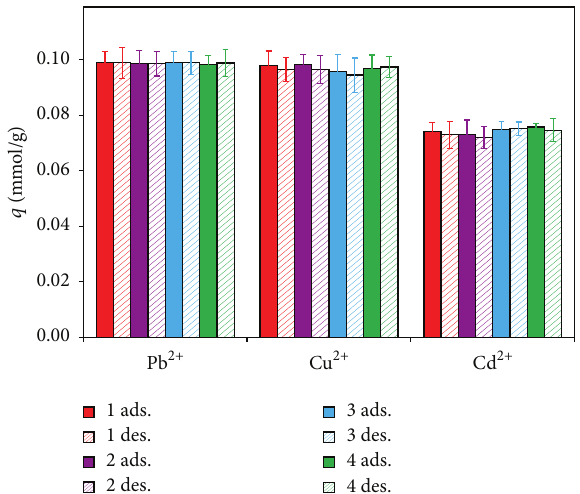
Figure 4: Adsorption-desorption cycles of Pb 2+ , Cu 2+ , and Cd 2+ using nitric acid. Experimental conditions: 0.1 mM initial metal concentration, pH 4.5, and 25 ∘ C. Error bars represent standard deviation of triplicate measurements.